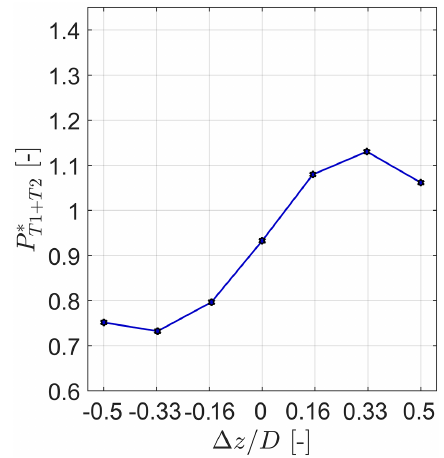
of the two-turbine Figure 9. Combined relative power P ∗ T 1 + T 2 array for different lateral offset positions (cid:49)z/D . The combined power is calculated for a change of upstream turbine yaw angle from γ T1 = 0 to + 30 ◦ for each position. The downstream turbine T2 is located at x/D = 3. The turbines are exposed to inflow